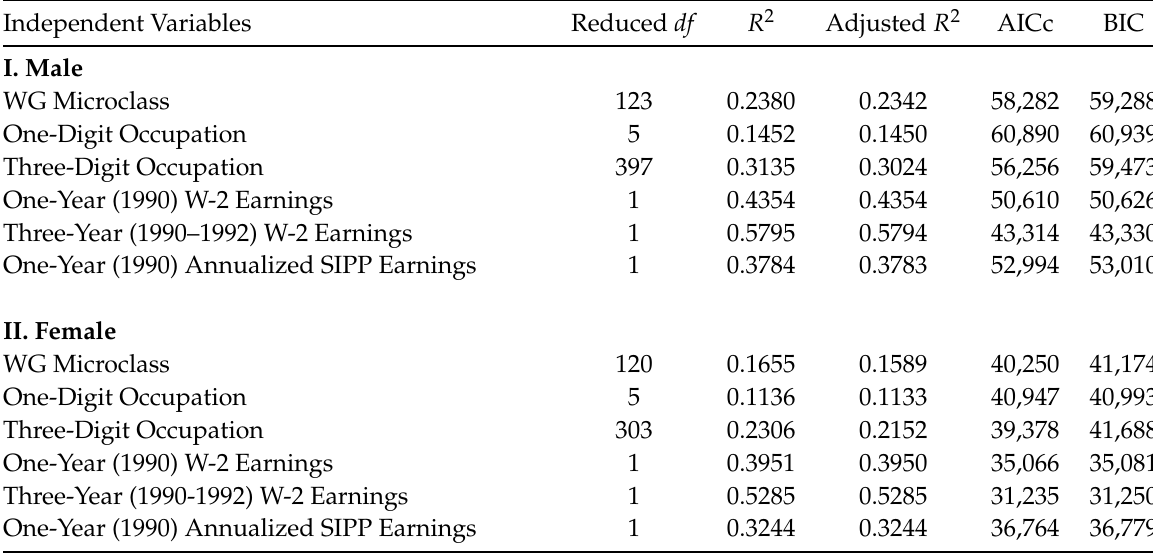
Table 5: Results for OLS models of log–long-term earnings using the imputed sample to create Weeden–Grusky